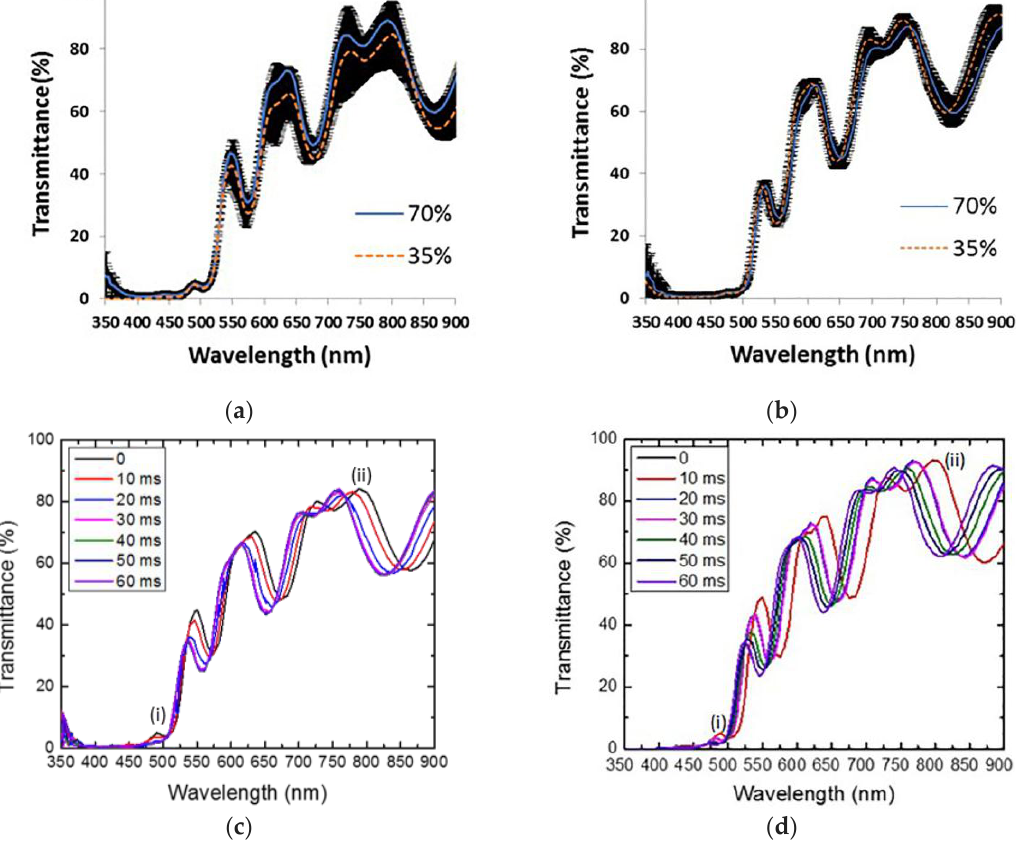
Figure 3. Sensing measurements result for two different ethanol concentrations (70% and 35%). ( a ) Average transmission spectra (three trials for each concentration) at 0 ms. ( b ) Average transmission spectra (three trials for each concentration) at 60 ms. The black band represents a one-standard error. In both cases, the average lies within the error band, meaning that, on average, both mode peaks begin and end at the same wavelength position. ( c ) Example of one trial showing the wavelength shift towards low energy with a concentration of alcohol of 70%; ( d ) The same as ( c ) with a concentration of alcohol of 35%.